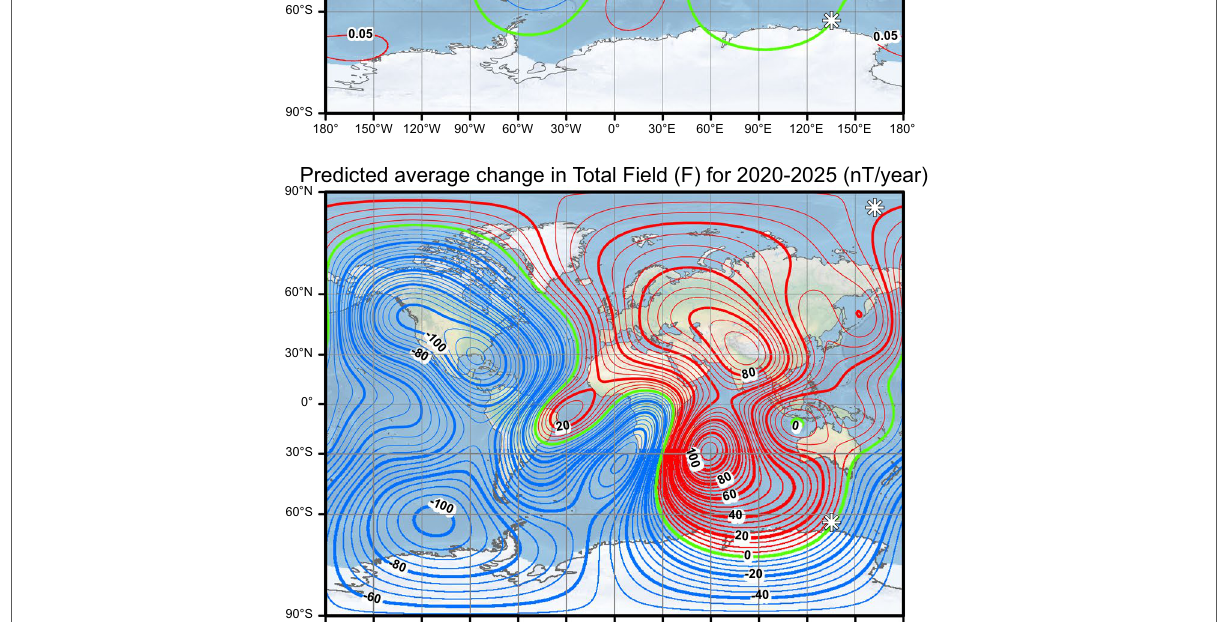
Fig. 2 Maps of predicted annual secular variation in declination (top), inclination (middle) and total field (bottom) at the WGS84 ellipsoid surface averaged over 2020 to 2025. The zero contour is shown in green, positive contours in red, and negative contours in blue. White asterisks indicate locations of the magnetic dip poles. Projection is Miller